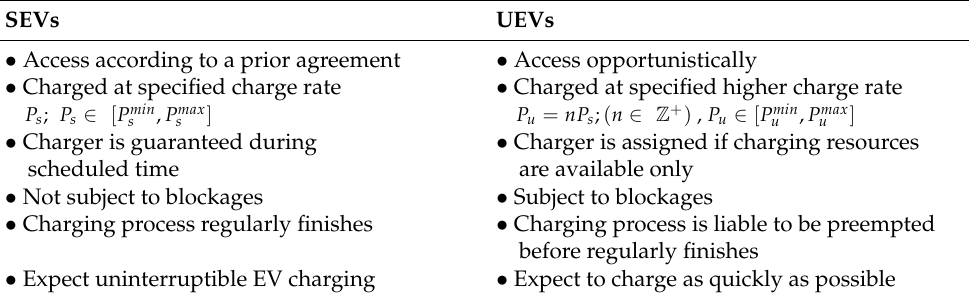
Table 1. Access privileges and constraints of EV users.